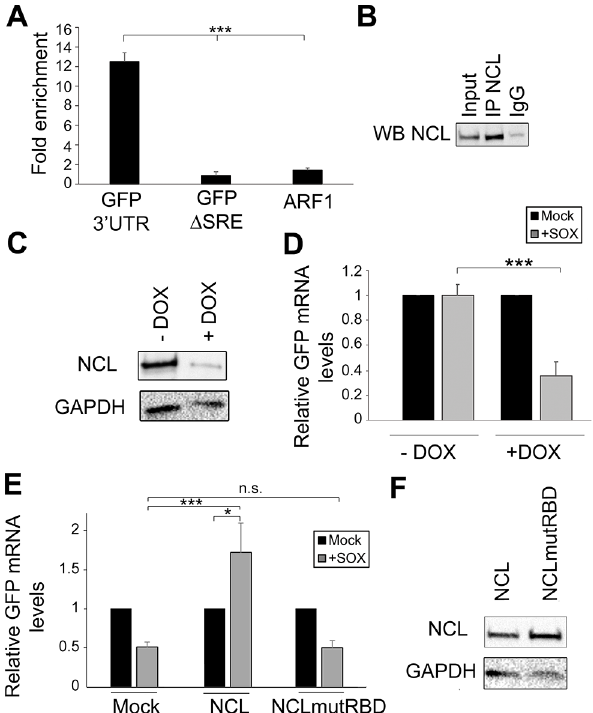
Fig 3. NCL binds the SRE in cells and contributes to IL-6 resistance. (A) 293T cells were transfected with the indicated GFP reporter, cross linked in 1% formaldehyde for 10 min, and lysed. Lysates were subjected to RNA immunoprecipitation (RIP) with anti-NCL (or mock IP with IgG) and the co-purifying mRNA was quantified by RT-qPCR. Bars represent the fold enrichment over mock IP. ARF1, an a priori NCL non-target, was included as a negative control. (B) Western blot showing the expression levels of NCL in the RIP input or post IP. (C) 293T Δ NCL cells were treated with doxycycline (DOX) to induce NCL depletion, then lysates were Western blotted for NCL or GAPDH as loading control. (D) 293T Δ NCL were incubated +/- DOX, then subsequently transfected with the GFP 3 ’ IL-6 plasmid alone or together with a SOX expression plasmid. 24h later GFP mRNA levels were quantified by RT-qPCR. (E) DOX-treated 293T Δ NCL cells were co-transfected with GFP-3 ’ IL-6 and the indicated WT or mutant NCL expression plasmid +/- SOX. 24h later GFP mRNA levels were quantified by RT-qPCR. (F) Western blot showing the expression levels of NCL or GAPDH as loading